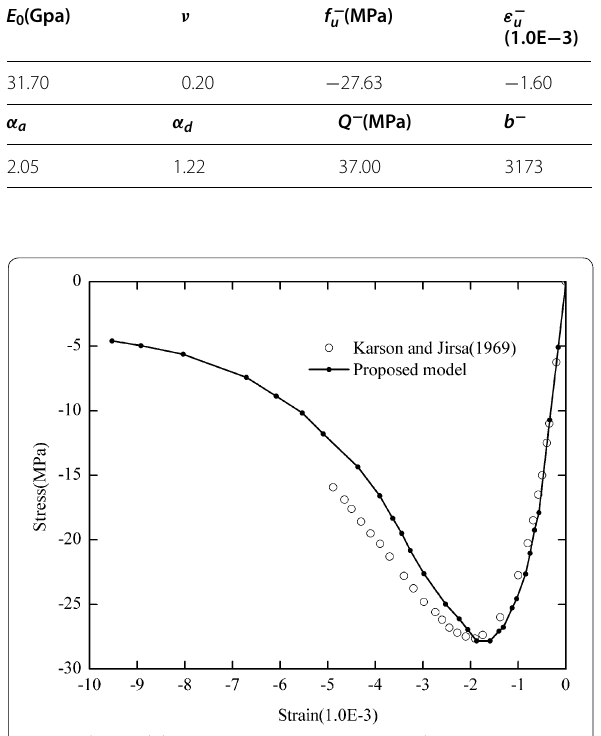
Fig. 8 The model responses in monotonic uniaxial compression compared to experimental results presented in Karsan and Jirsa